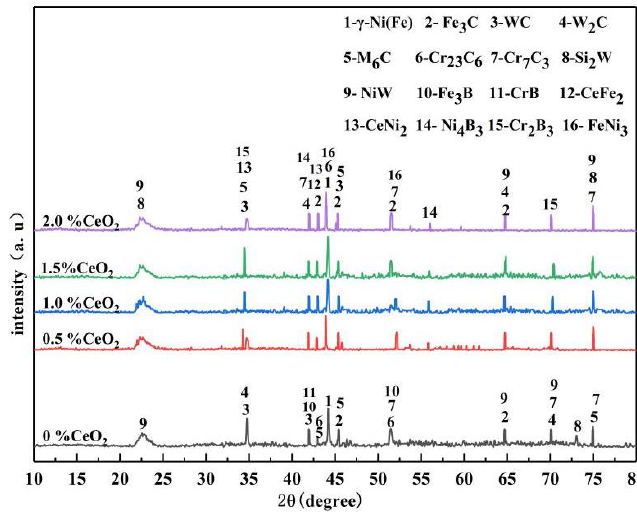
ff erent coatings.